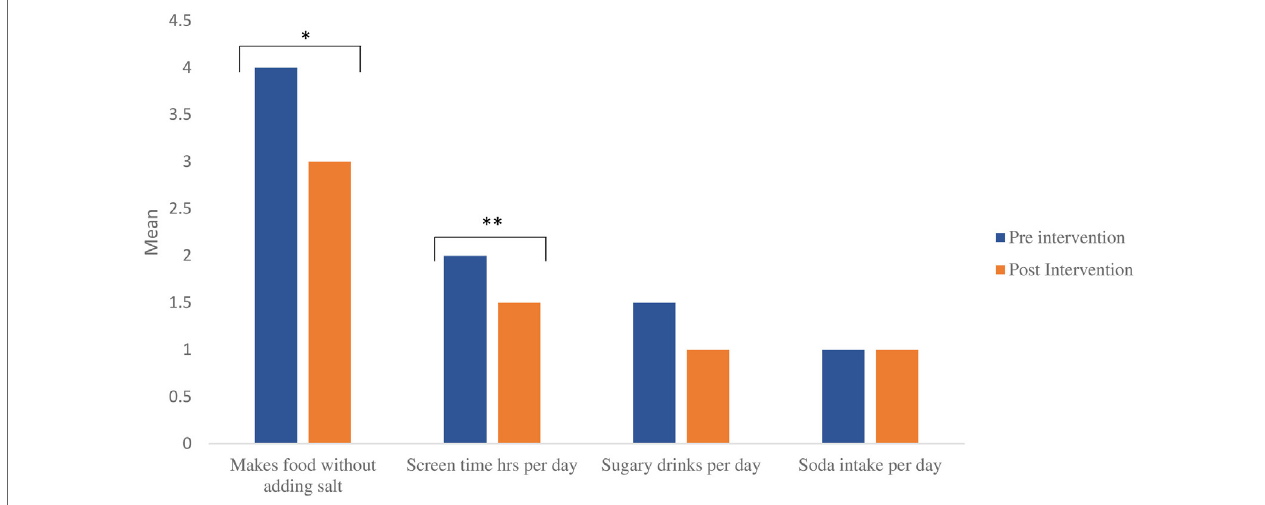
FigUre 3 | Food and nutrition behaviors of shape-up and eat right families pre- and post-intervention (data for program completers). Legend: 1 = no, 2 = sometimes, 3 = often, 4 = very often, 5 = almost always; * p = 0.029, ** p = 0.034; for sugary drinks and soda intake, value on Y -axis corresponds with numeric value per